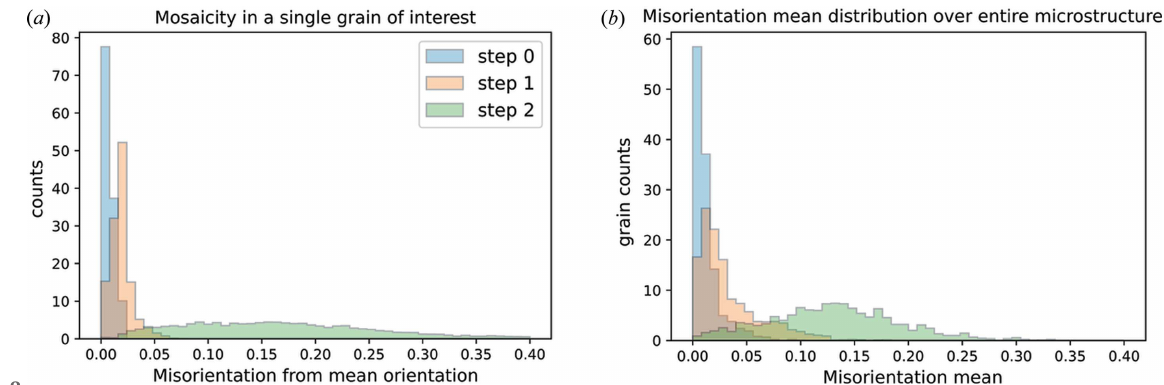
Figure 8 Statistical data extracted from the orientation data: ( a ) evolution of mosaicity on an entire grain of interest and ( b ) misorientation mean distribution evolution over the entire